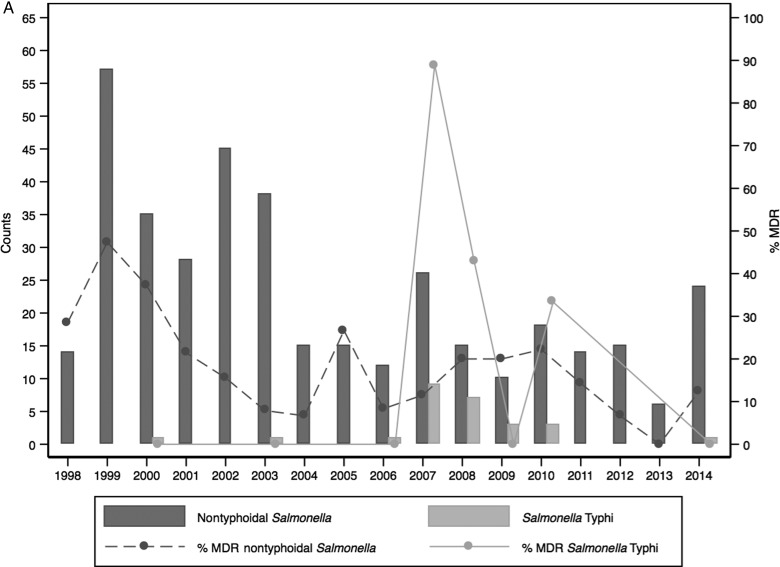
The relationship between multidrug resistance (MDR) and the number of nontyphoidal Salmonella (NTS) and Salmonella Typhi (A) or the number of NTS isolates per serotype (B) among children, August 1998–2014.